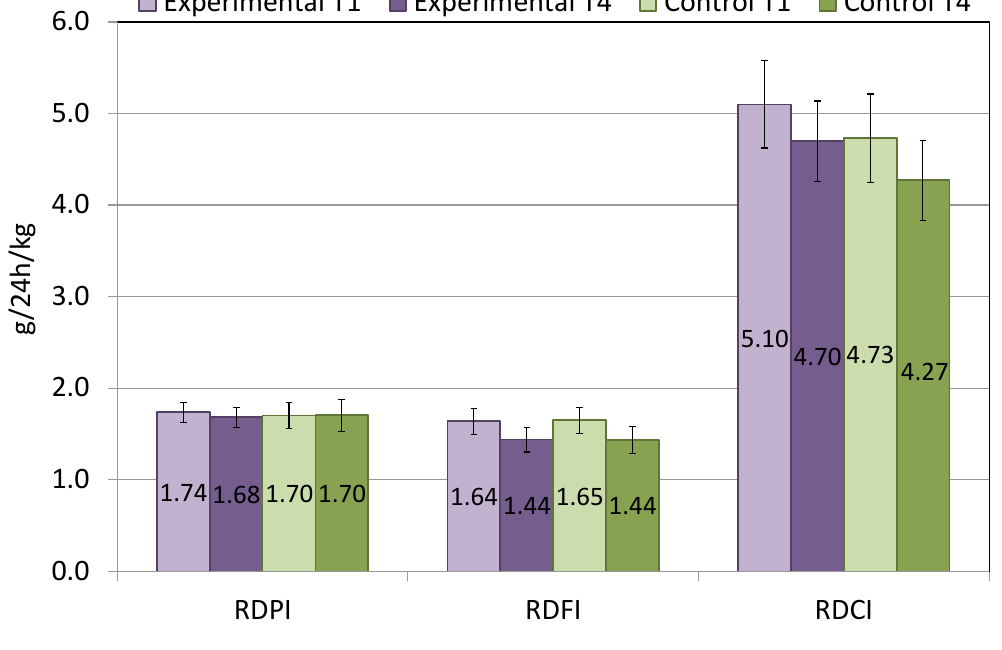
Figure 3. Relative daily protein intake (RDPI), relative daily fat intake (RDFI) and relative daily carbohydrate intake (RDCI) of the swimmers from the experimental (n=12) and the control (n=12) groups on the 1 st (T1) and the 42 nd (T4) days of the six-week training